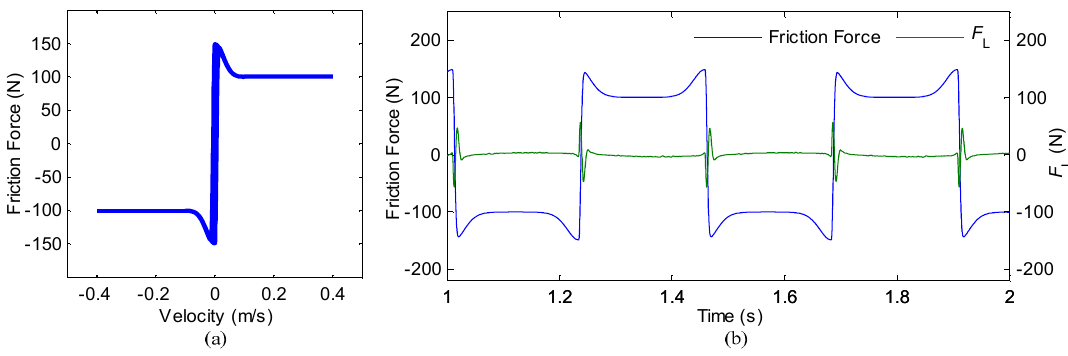
Figure 18. Effect of friction on suppression, ( a ) friction model with Stribeck effect; ( b ) corresponding graph of friction force and F L in the time domain with disturbance 7sin14 t